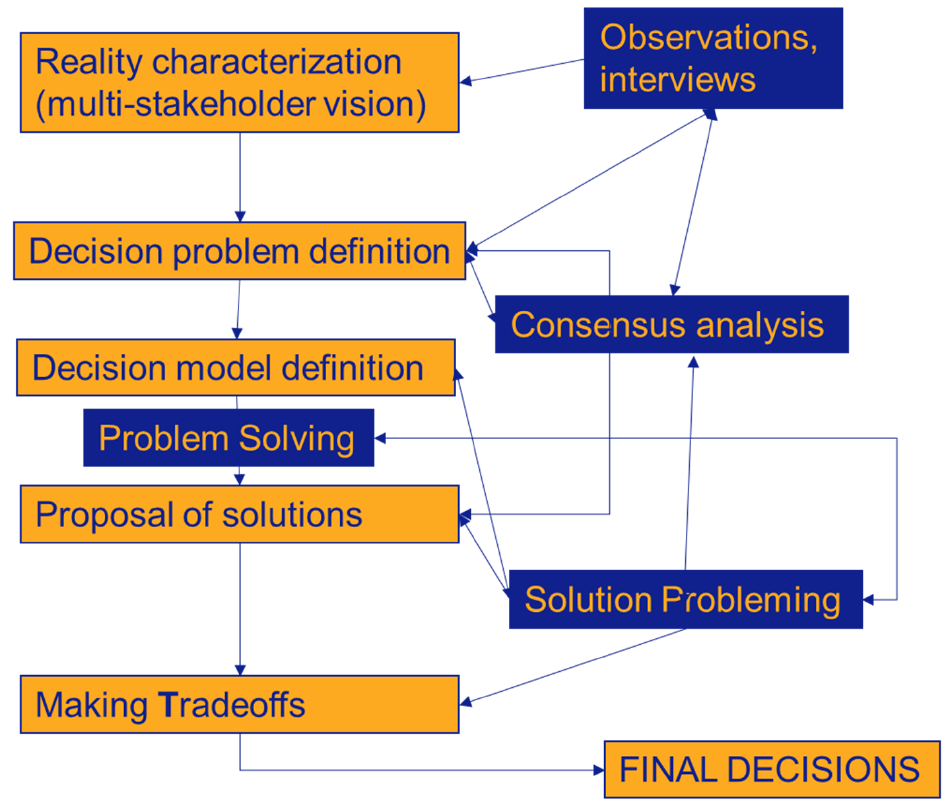
Figure 2. The problem-solving cycle adapted to the mixed-method case study, elaborate by authors from considerations in [36,41].